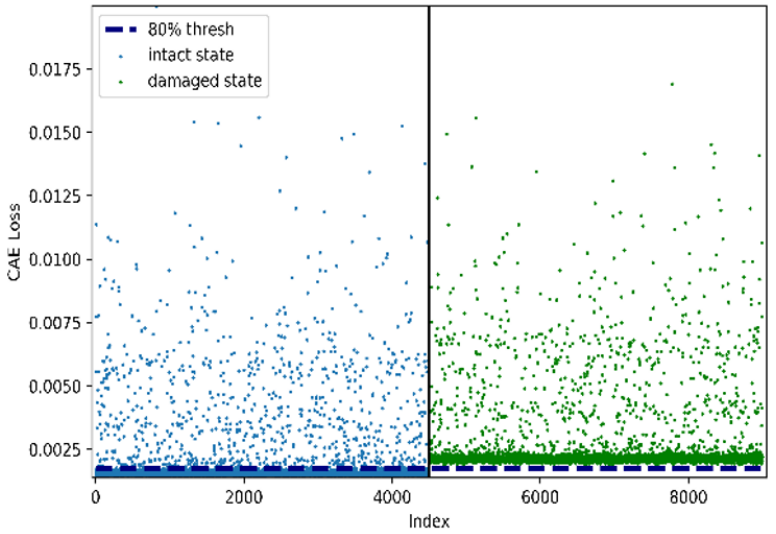
Figure 8. Example of scatter plots for CAE losses with each damage case and error level for rigid- frame-bridge modeling.